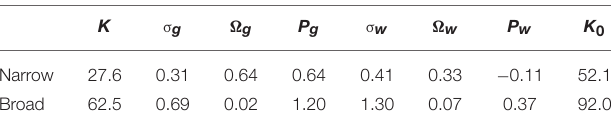
TABLE 1 | The optimal parameters of W and G function fitted with narrow and broad group of